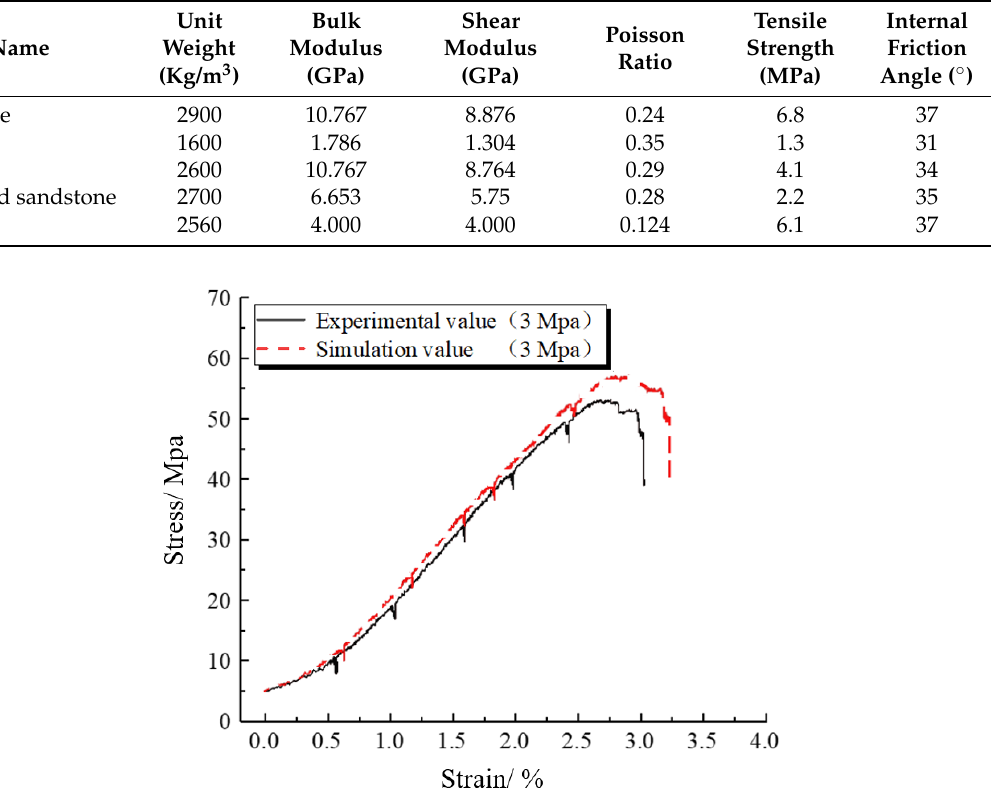
Table 1. Mechanical parameters input.